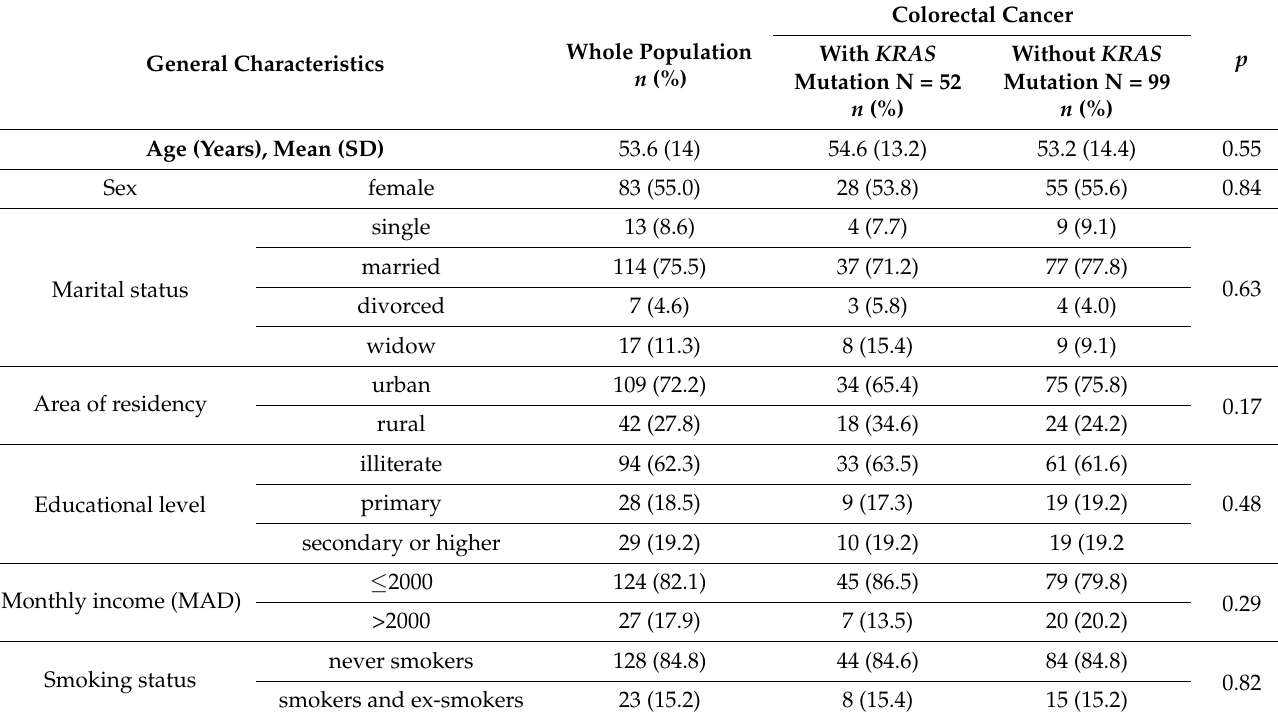
Table 2. General characteristics of the overall study population and the colorectal cancer cases stratified by the presence of KRAS mutations (N =